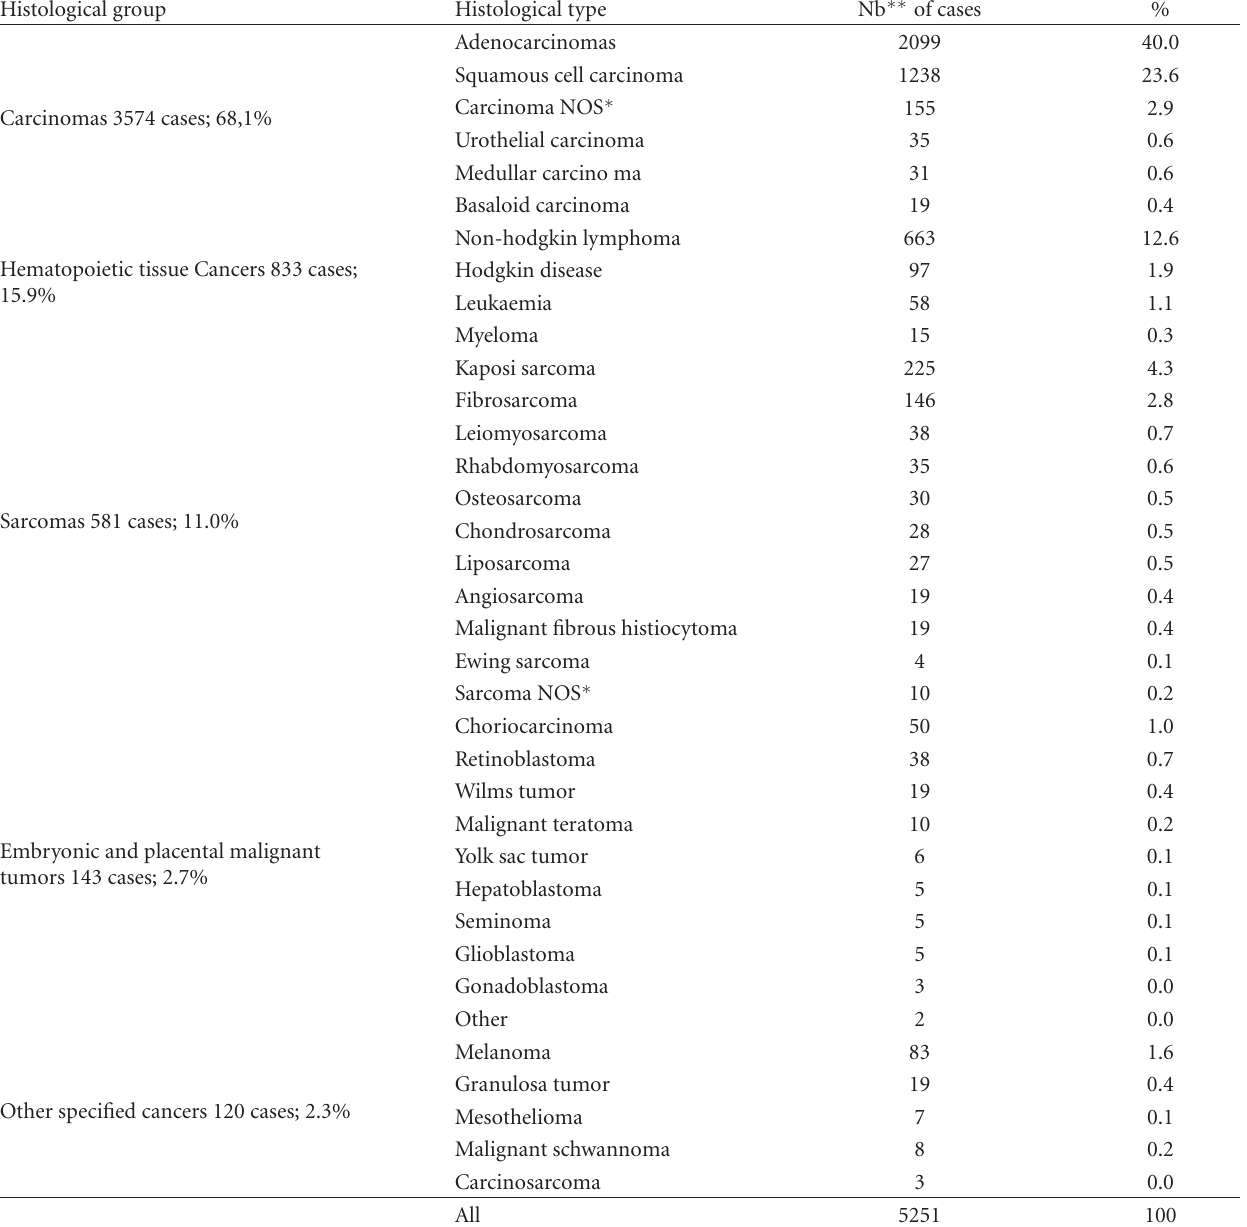
Table 4: Distribution of cancers by histological